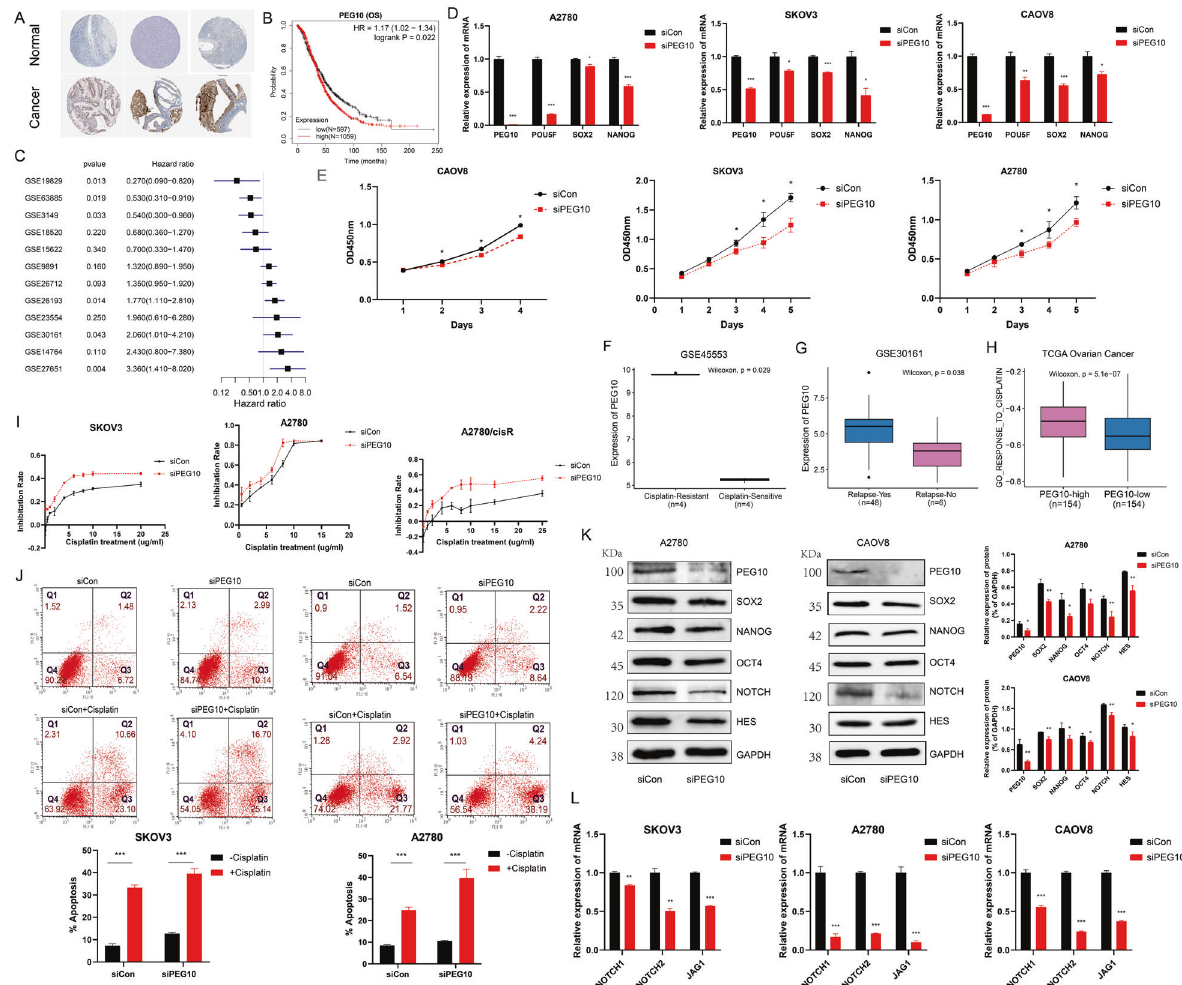
Fig. 4 PEG10 de fi ciency inhibits tumour cell proliferation and promotes cisplatin resistance by targeting stem cell self-renewal. A Representative protein expression levels of PEG10 were high in OCs based on the Human Protein Atlas database. B Patients with higher PEG10 illustrated poor OS based on Kaplan – Meier plotter data set. The cut-off of PEG10 was 1038 to dichotomise OC patients. C Forest plot showing PEG10 is associated with poor OS in most OC data sets. D Barplots demonstrating mRNA expression of SOX2, NANOG, and POU5F were lower in siPEG10 cells. E Downregulation of PEG10 inhibited OC cell proliferation. F , G Boxplot illustrating higher PEG10 in cisplatin resistant ( F ) and relapse ( G ) group based on GEO data sets. H GSVA of GO_RESPONSE_TO_CISPLATIN in the high- and low-PEG10 group. I Cisplatin sensitivity in siCon and siPEG10 OC cells. J Apoptotic cells by fl ow cytometry in control and siPEG10 OC cells untreated or treated with cisplatin. K Protein levels of PEG10, SOX2, NANOG, OCT4, NOTCH, and HES were also lower in siPEG10 OC cells. L mRNA levels of NOTCH1, NOTCH2, and JAG1 were lower in the siPEG10 group compared to the siCon group. *represented p < 0.05, **represented p < 0.01, ***represented p <